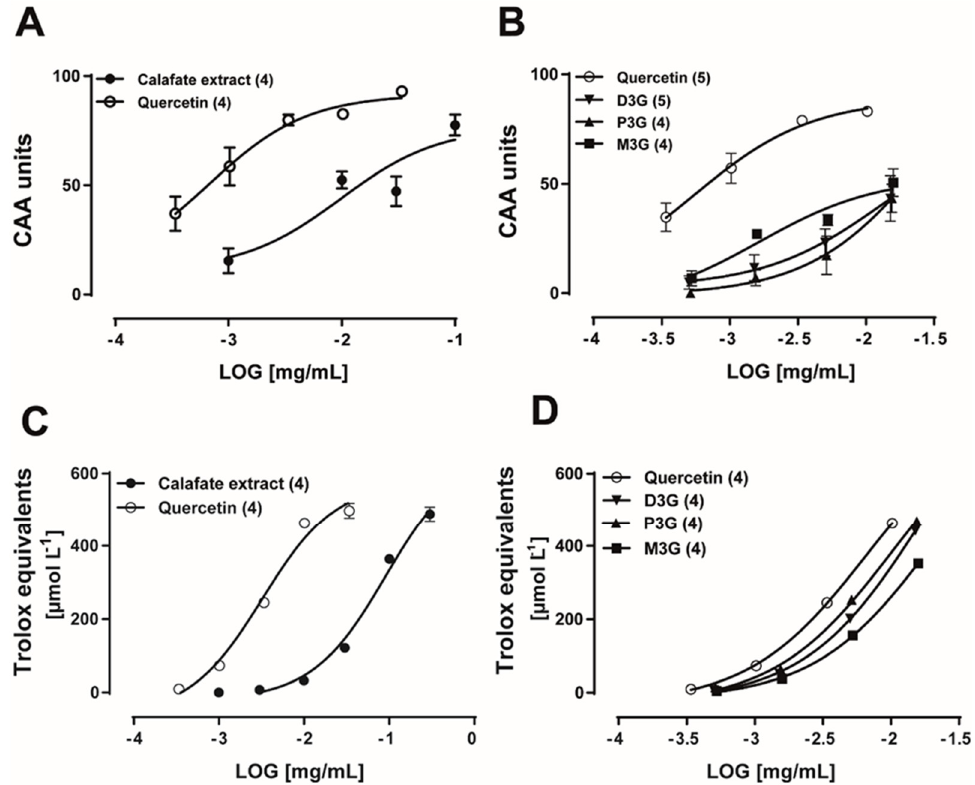
Figure 3. Comparison of the antioxidant activity of the extract and major extract anthocyanins by two methods: the cellular antioxidant activity (CAA) versus the DPPH assay. ( A ) Calafate extract and quercetin control antioxidant concentration–response curves. ( B ) Antioxidant effect of the three major Calafate anthocyanins in the CAA assay measured in endothelial cells examined in the same concentration range that caused vasodilatation. Calafate extract antioxidant activity measured by the DPPH assay and its comparison with quercetin ( C ) or the three major extract anthocyanins ( D ). Symbols represent the mean values, bars the SEM. While the CAA activity is expressed in relative units, the DPPH assay is expressed in Trolox equivalents.